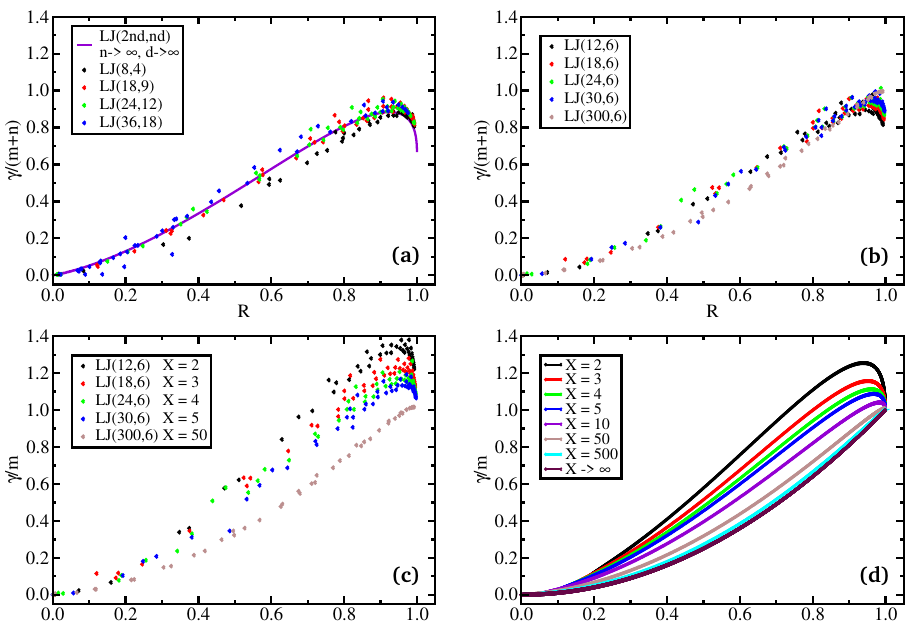
Figure 4: ( R , γ ) diagrams for several LJ potentials in fixed dimension d = 3. For each system the state points studied are from the six isochores defined by ρ = 0.25 – 1.50 with 0.25 increment, and the temperature range is T = 0.25 – 1.0 by steps of 0.25 and T = 1.0 – 5.0 by steps of 0.5. For LJ ( 300,6 ) only four isochores were simulated ( ρ = 0.25,0.5,0.75,1.0). State points with negative R , corresponding to liquid- vapor coexistence, and state points corresponding to ordered states are not shown for the reasons discussed in Sec. 4.1. (a) LJ ( 2 nd , nd ) with n ∈ { 4 / 3,3,4,6 } . The solid line is the n → ∞ virial prediction Eq. (15). These data were first presented in Ref. [ 25 ] . (b) (c) (d) LJ ( X nd , nd ) ( d = 3, n = 2) for several ratios X . (b) For X = 2,3,4,5,50, R versus the rescaled γ/ ( m + n ) vary little. For X > 50 the shape changes qualitatively. The infinite-temperature R = 1 endpoint varies slightly with X , as γ/ ( m + n ) = X / ( X + 1 ) , panels (c),(d). In App. A we show that when X becomes large, the natural scaling variable is γ/ m . This is seen both in MD simulations (c) and from Eqs. (13)